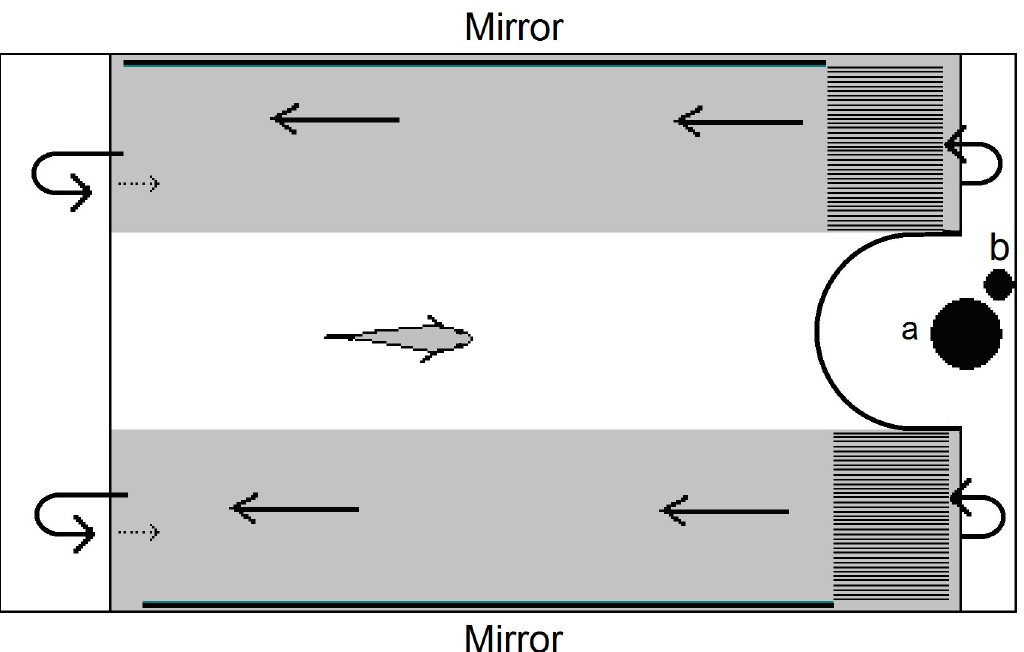
Figure 1. A diagram of the laterality test. Subjects swim against the water flow and maintain station with their mirror image on the left or right side of the apparatus. Arrows indicate water flow in the experimental area (solid lines) and the section below (broken lines). Grey areas are regions of laminar flow generated by banks of straws. The central area is an area of low flow generated by a baffle. The location of the (a) pump and (b) heater are